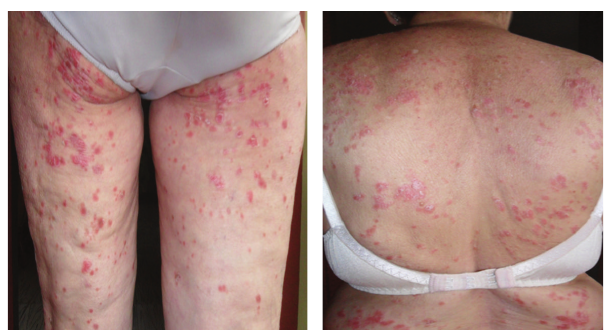
Figure 1: Erythematosus and desquamative papules with central scaling on the back and arms.